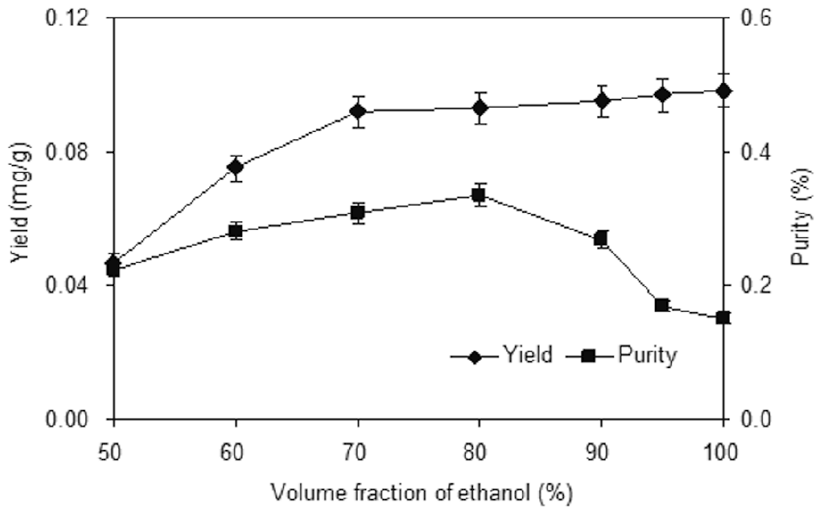
Figure 2. Effect of ethanol volume fraction on the yield and purity of